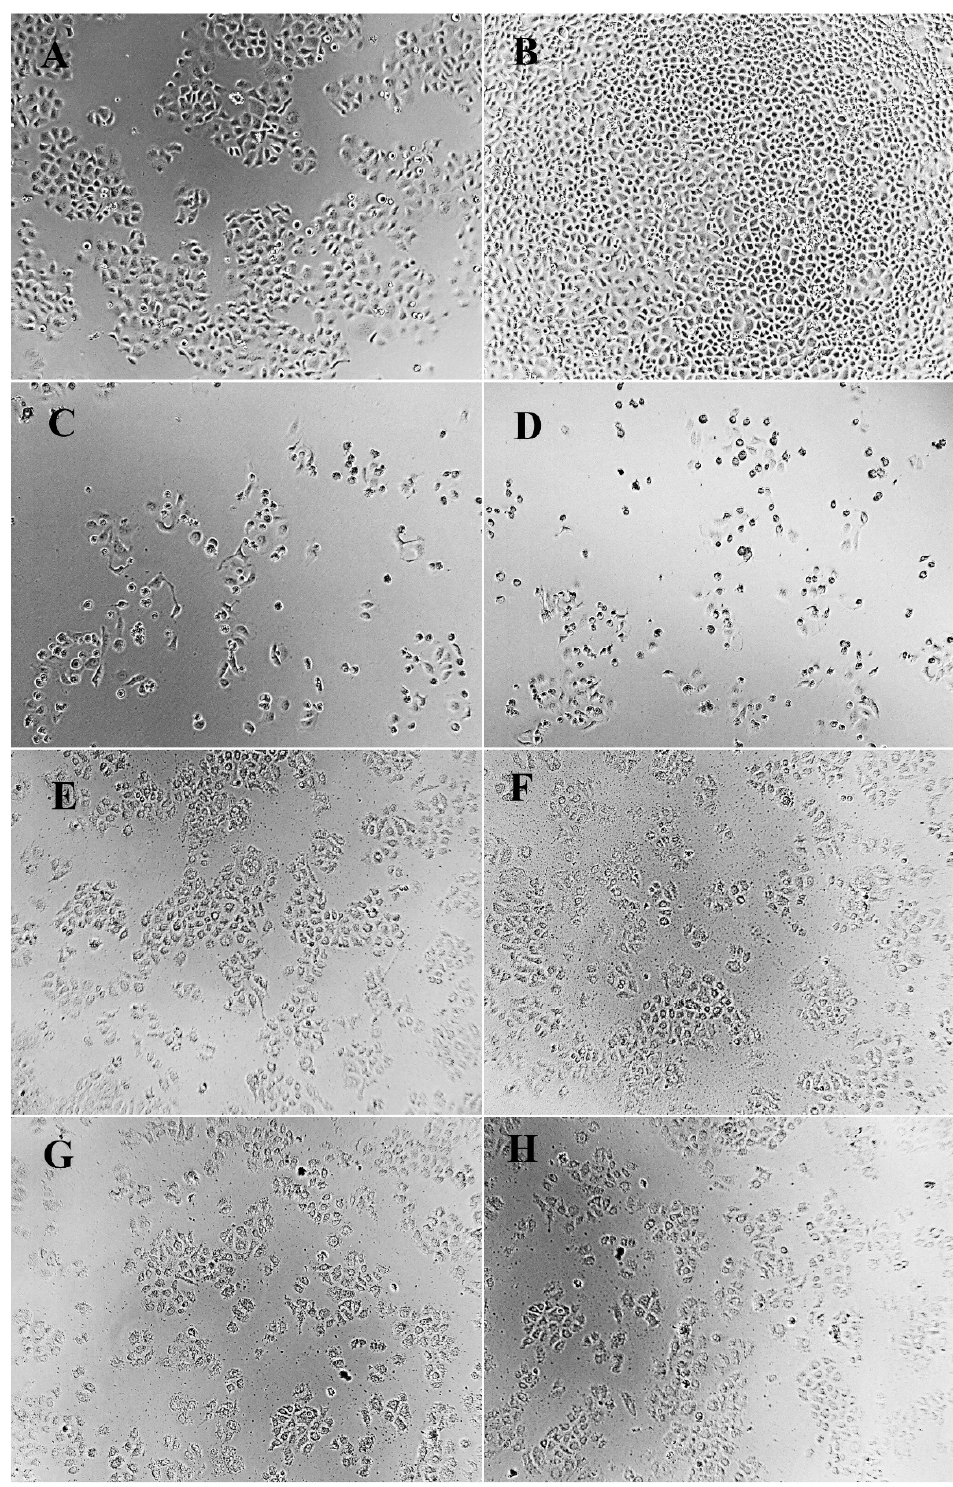
Figure 4. Effect of PPCFCTL on morphology of HeLa cells. Negative control group (( A ) 24 and ( B ) 48 h), 150 µg/mL 5-FU treatment group (( C ) 24 and ( D ) 48 h), 750 µg/mL PPCFCTL treatment group